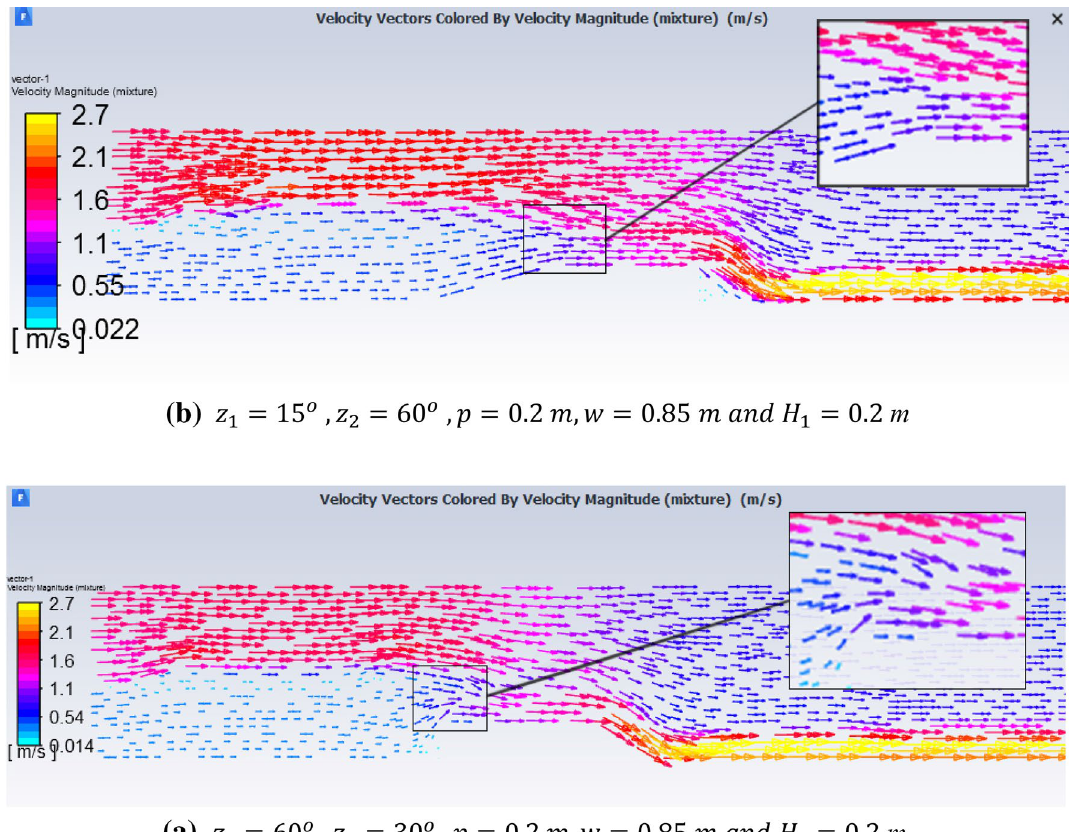
Fig. 5 Velocity vectors for flow over broad-crested weirs including upstream and downstream slope